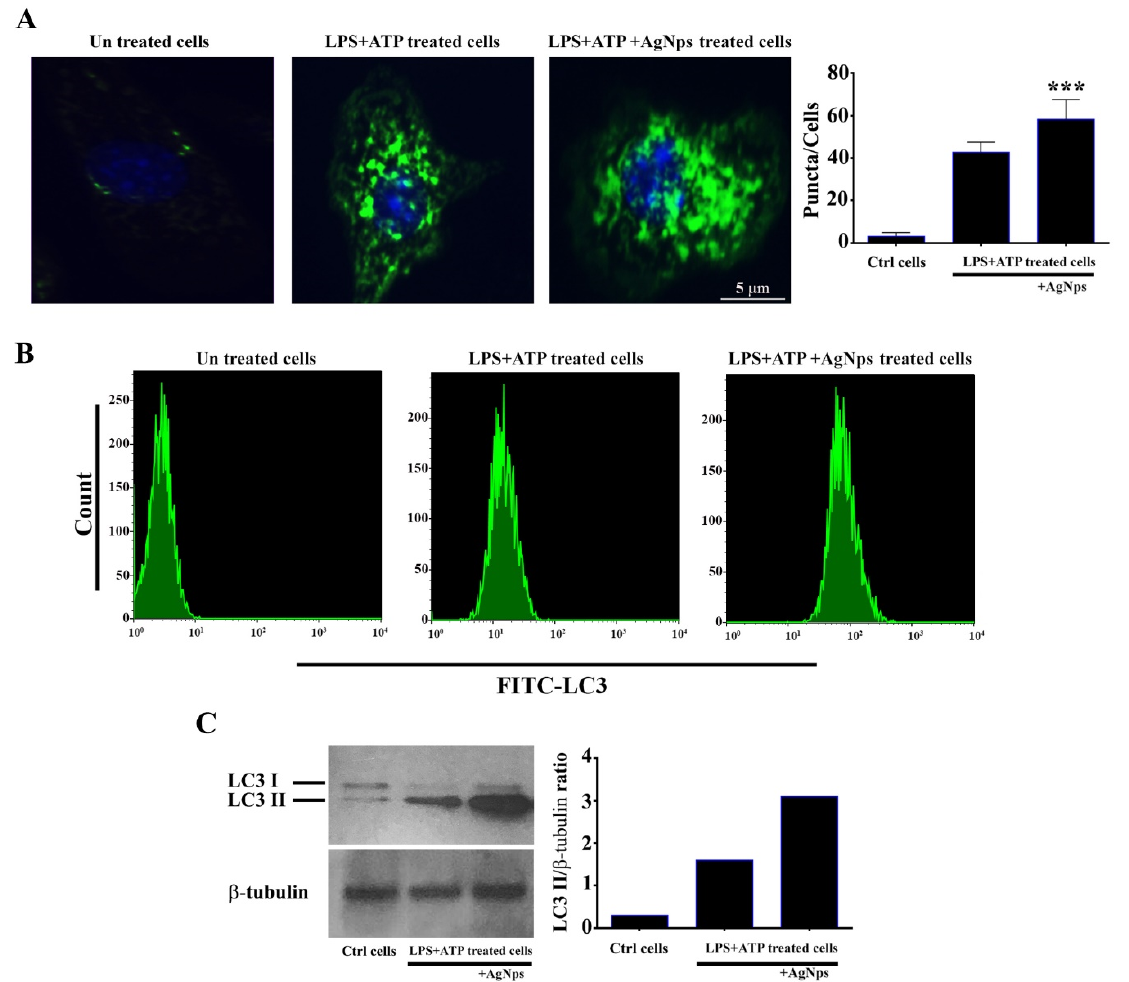
Figure 8. AgNPs augmented autophagy following LPS+ATP treatment of cells. ( A ) Immunofluorescence graphs of LC3 in bone marrow-derived macrophages (BMDMs). Cells were treated, or not, with LPS+ATP in the presence and absence of 5 μ gmL − 1 AgNPs. Fixation, permeabilization, and staining with DAPI were performed to visualize nuclei (blue); autophagosome staining appears in green. Scale bar, 5 μ m. Graph represents numbers of LC3 puncta in cells after treatment with LPS+ATP, with and without AgNPs treatment (5 μ gmL − 1 ); quantification of the results was performed with Image J software. Asterisks refer to statistical difference between cells with and without treatment with 5 μ gmL − 1 AgNPs. Results are expressed in mean ± SD. *** p < 0.001. ( B ) Flow cytometry analysis for LC3 protein in BMDMs following treatment with LPS+ATP, with and without treatment with 5 μ gmL − 1 AgNPs. ( C ) Western blot analysis of LC3-I and LC3-II proteins. Cells left untreated as control or treated with LPS+ATP in absence and absence of AgNPs at a concentration of 5 μ gmL − 1 . Graph represented densitometry quantification of the LC3-II/b-tubulin ratio, as indicated.